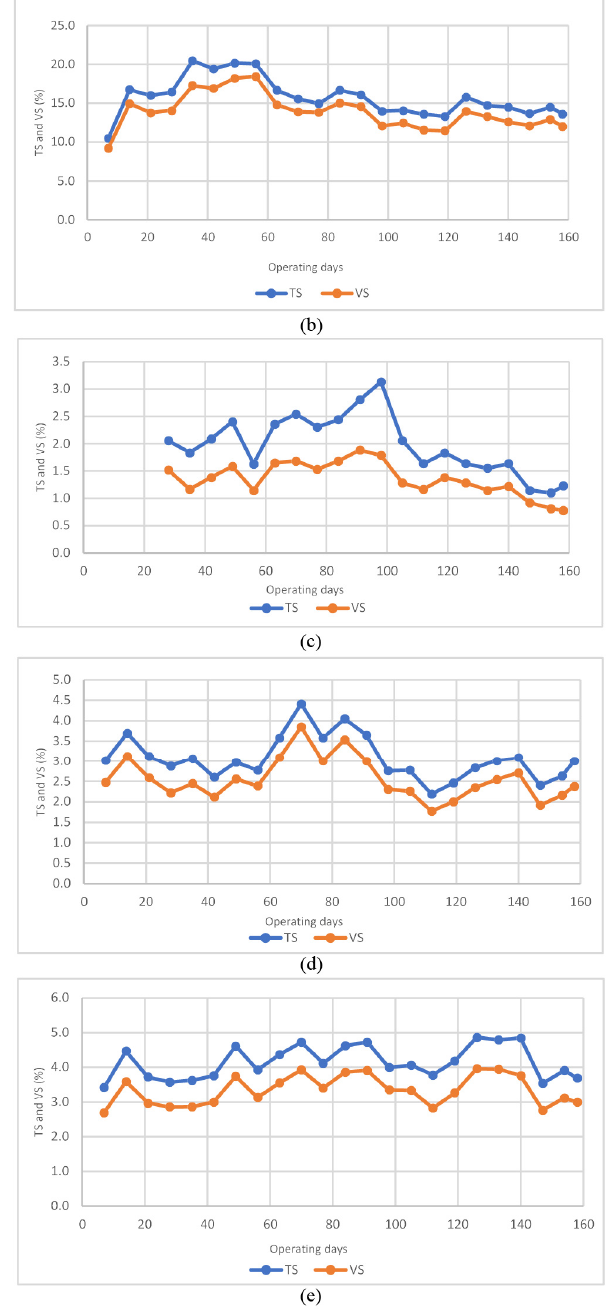
Figure 7. Change in the TS and VS content of ( a ) pig manure, ( b ) food waste, ( c ) excretion, ( d ) thick- ened sewage sludge, and ( e ) mixed waste.